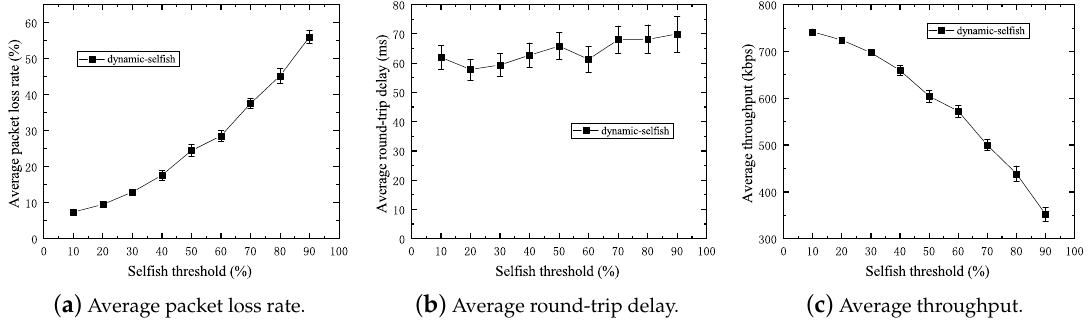
Figure 6. Performance impact of various selfish thresholds (50